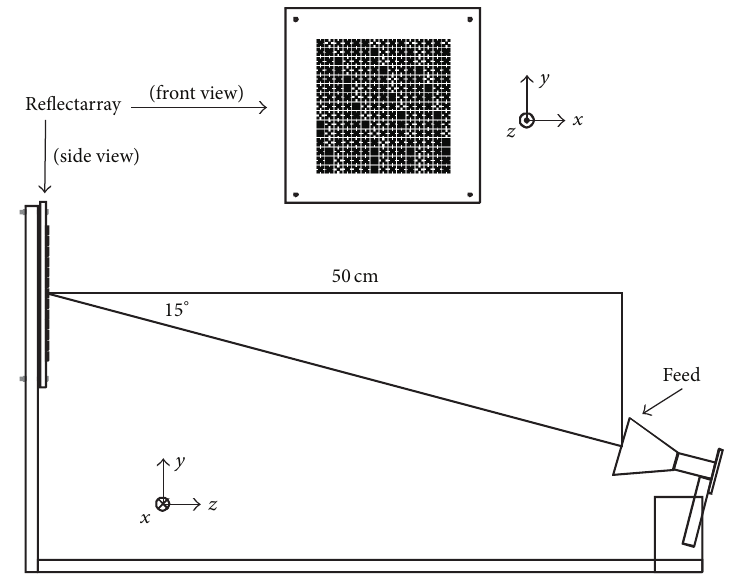
Figure 20: Reflectarrays layout.